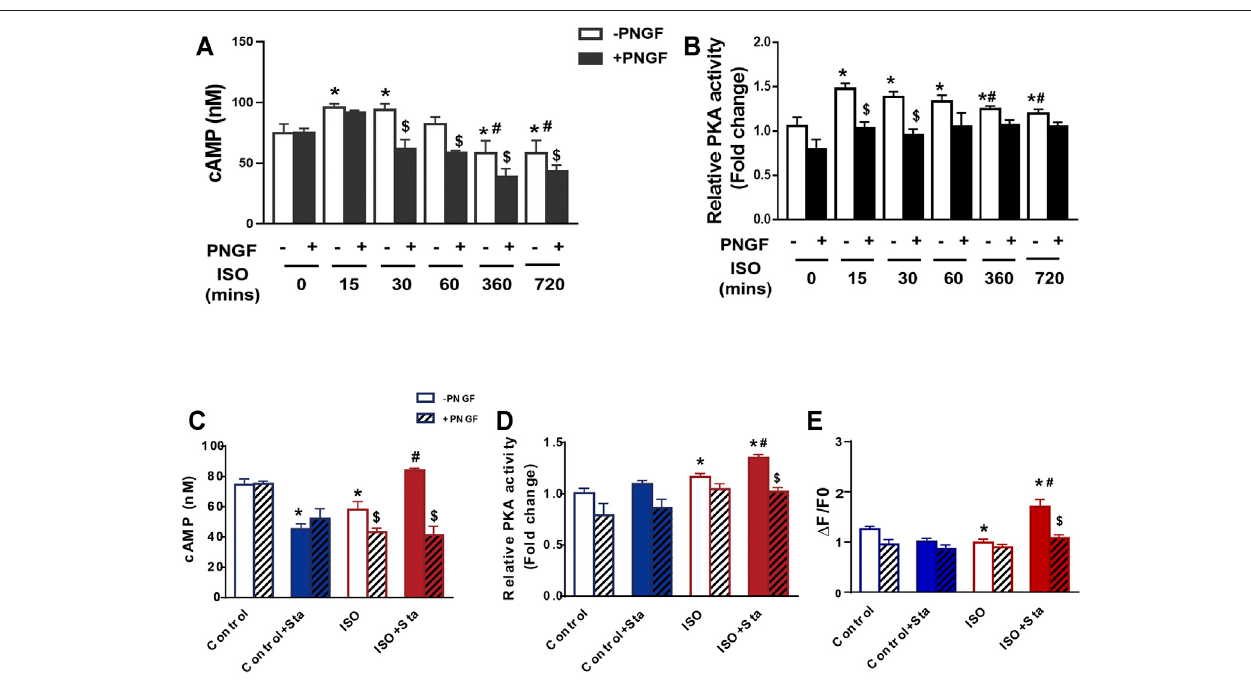
FIGURE 6 | Decreased N glycosylation of β 1AR will downregulate the β 1AR/cAMP/PKA signal pathway. (A) Quanti fi cation of cAMP production after PNGase F digestionexposedtoISOatdifferenttimepointsinH9C2cells(fromthreeindependentexperiments). (B) Quanti fi cationofPKAactivityafterPNGaseFdigestionexposed to ISO at different time points in NRVMs (from three independent experiments). (C,D) Quanti fi cation of Sta on cAMP production and PKA activity exposed to ISO at 720 min (from three independent experiments). (E) Quanti fi cation of Ca 2+ transient parameters exposed to ISO at 720 min in AMVMs ( n = 15 cells from 3 mice in each group). Thedata are expressed as mean ±standard error ofmean, * p < 0.05 versus control; # p < 0.05 versusISO; $ p < 0.05 versus -PNGF. AMVMs, adult mouse ventricular myocytes; ISO, isoproterenol; Sta, stachydrine hydrochloride; NRVMs, neonatal rat ventricular